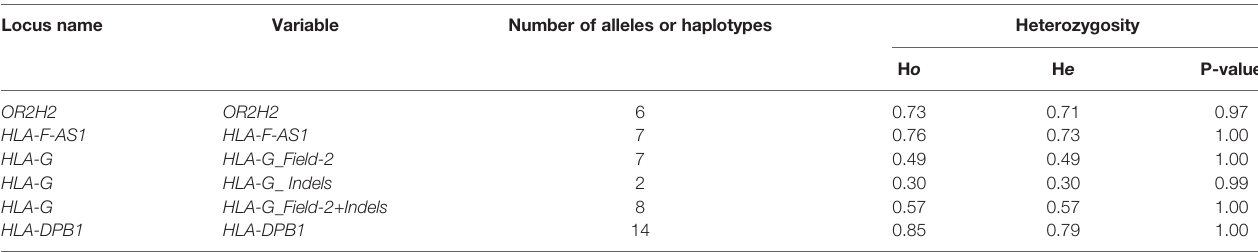
TABLE 3 | Heterozygosity of OR2H2 , HLA-F-AS1 , HLA-G , and HLA-DPB1